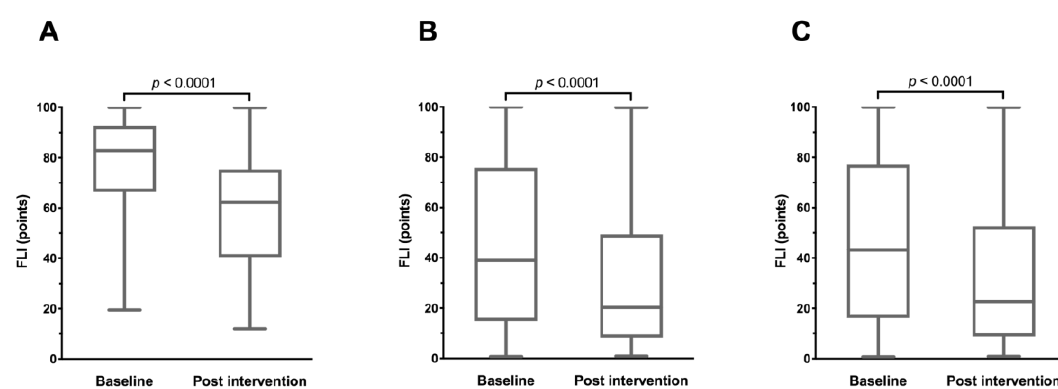
Figure 1. Changes in FLI before and after fasting in patients with T2DM ( A ), non-diabetic subjects ( B ), and all subjects ( C ). Nutrients 2019 , 11 , x FOR PEER REVIEW